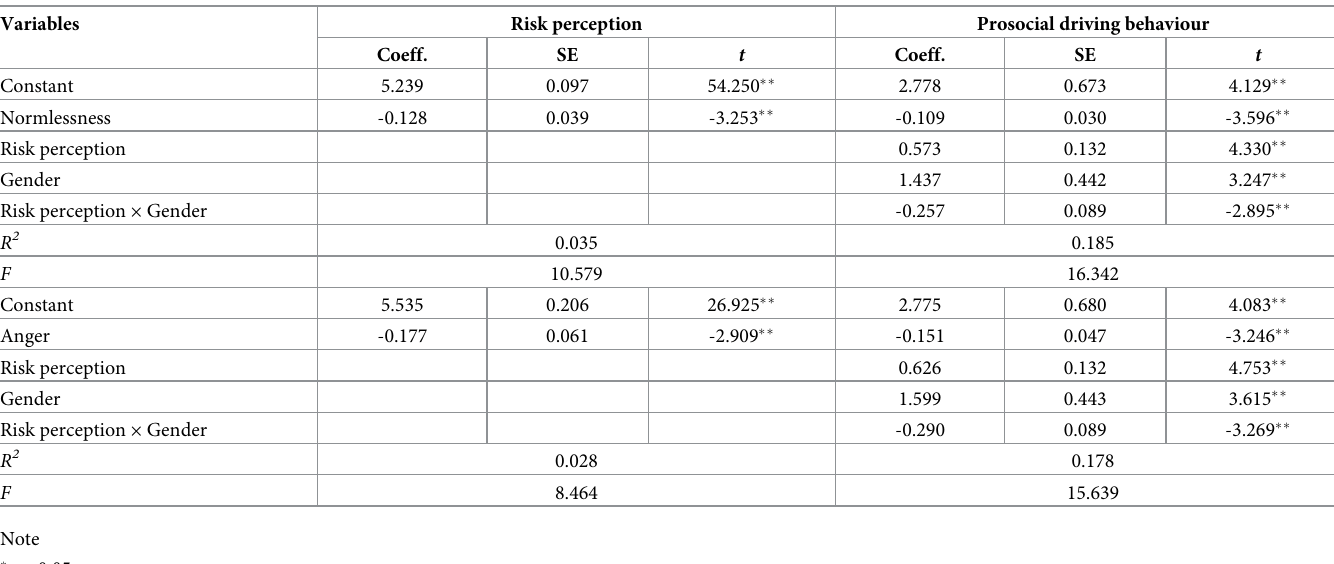
Table 4. Moderated mediation results of personalities on prosocial driving behaviour.